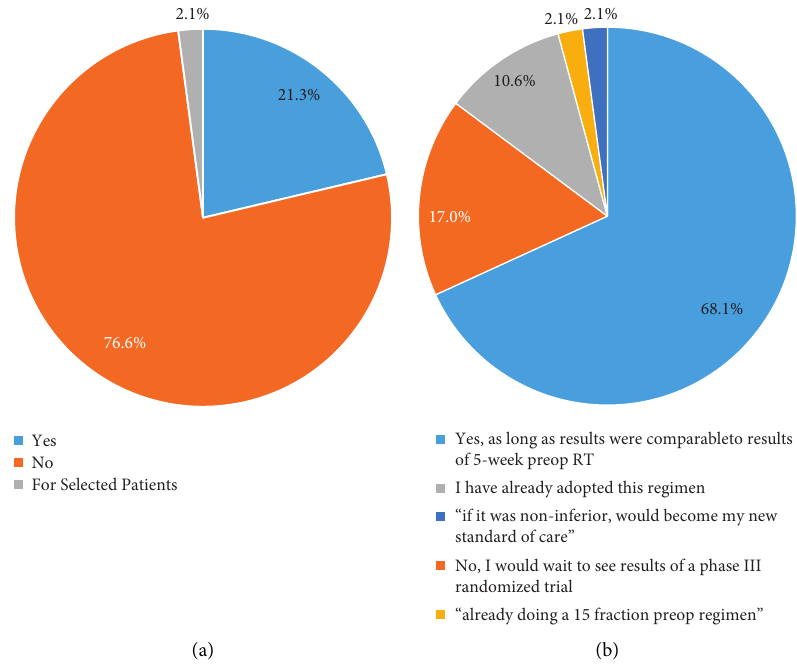
Figure 2: Viewpoints on the role of single-arm multisite phase II studies in changing radiotherapy standard of care in sarcoma. (a) Respondents ( n � 47) answered whether they currently consider 5-fraction preoperative RTto be a standard-of-care option. (b) Respondents ( n � 47) answered whether they would be willing to adopt a 5-fraction preoperative RTregimen if a sufficiently powered single-arm multisite phase II trial met their preferred clinical endpoint. Free-form responses are not included in the color-coded